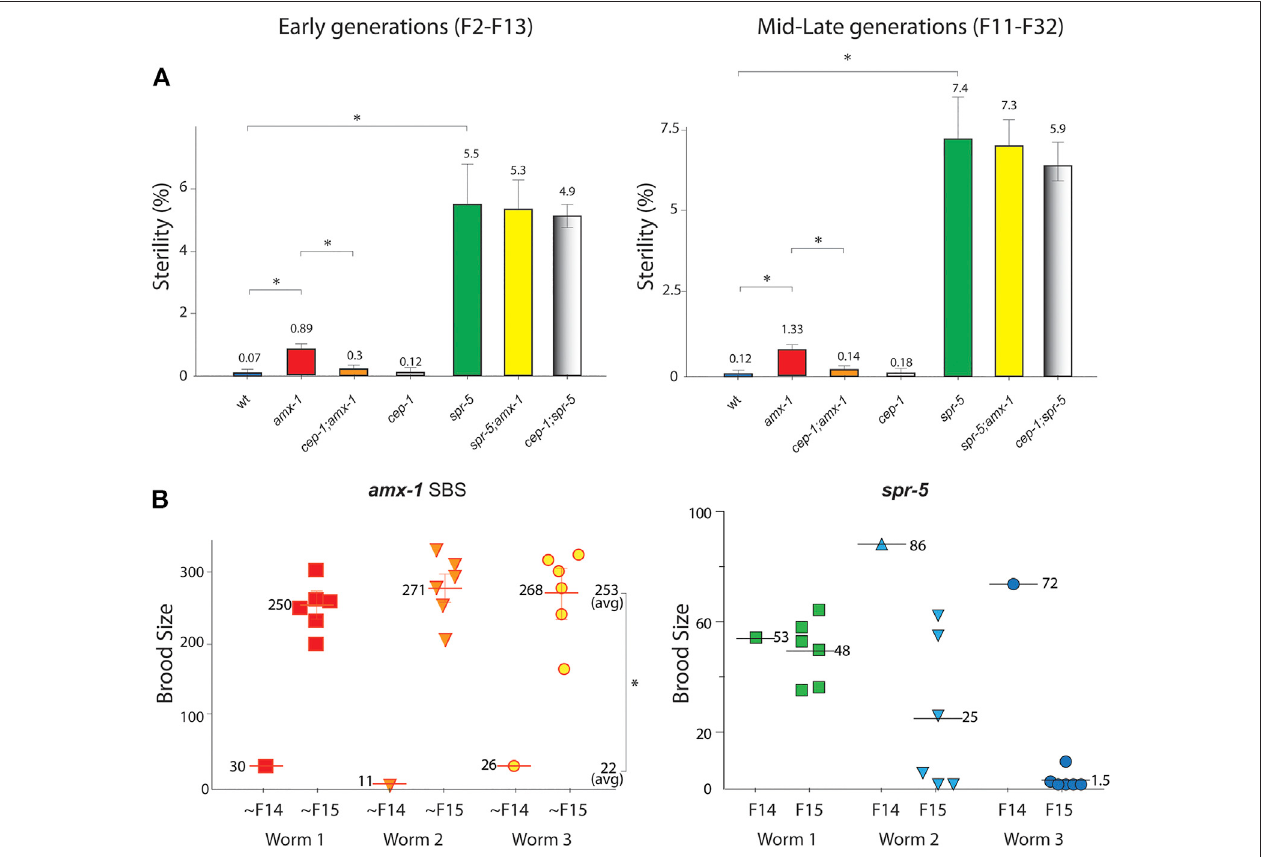
FIGURE 2 | Lack of amx-1 expression leads to non-transgenerational sterility in a CEP-1-dependent manner. (A) Sterility is scored among the progenies of indicated genotypes. amx-1 mutants exhibit sterility (zero brood size) compared to wild type in early (F2-F13) or mid-late generations (F11-F32). No obvious transgenerationaldeclinewasobservedbetweenearlyandmid-lategenerationsof amx-1 mutants( p =0.0006inearlyvs.mid-lategenerationsof amx-1 and p =0.0036 inearlyvs.lategenerationsof spr-5 ).Asterisksindicatestatisticallysigni fi cantchanges.Errorbarsrepresentstandarderrorsofthemean.n > 24foreachgenotype. At least a thousand worms are analyzed for each genotype at each generation reported in three independent biological replicates. (B) Brood size is scored among the progeniesofthreeindependentSBS(smallbroodsize) amx-1 mutants. averagebroodsize22vs. 253in~F14 and~F15 of amx-1 , p =0.0097;70vs.25inF14and F15 of spr-5 , respectively, p = 0.0233, Mann-Whitney